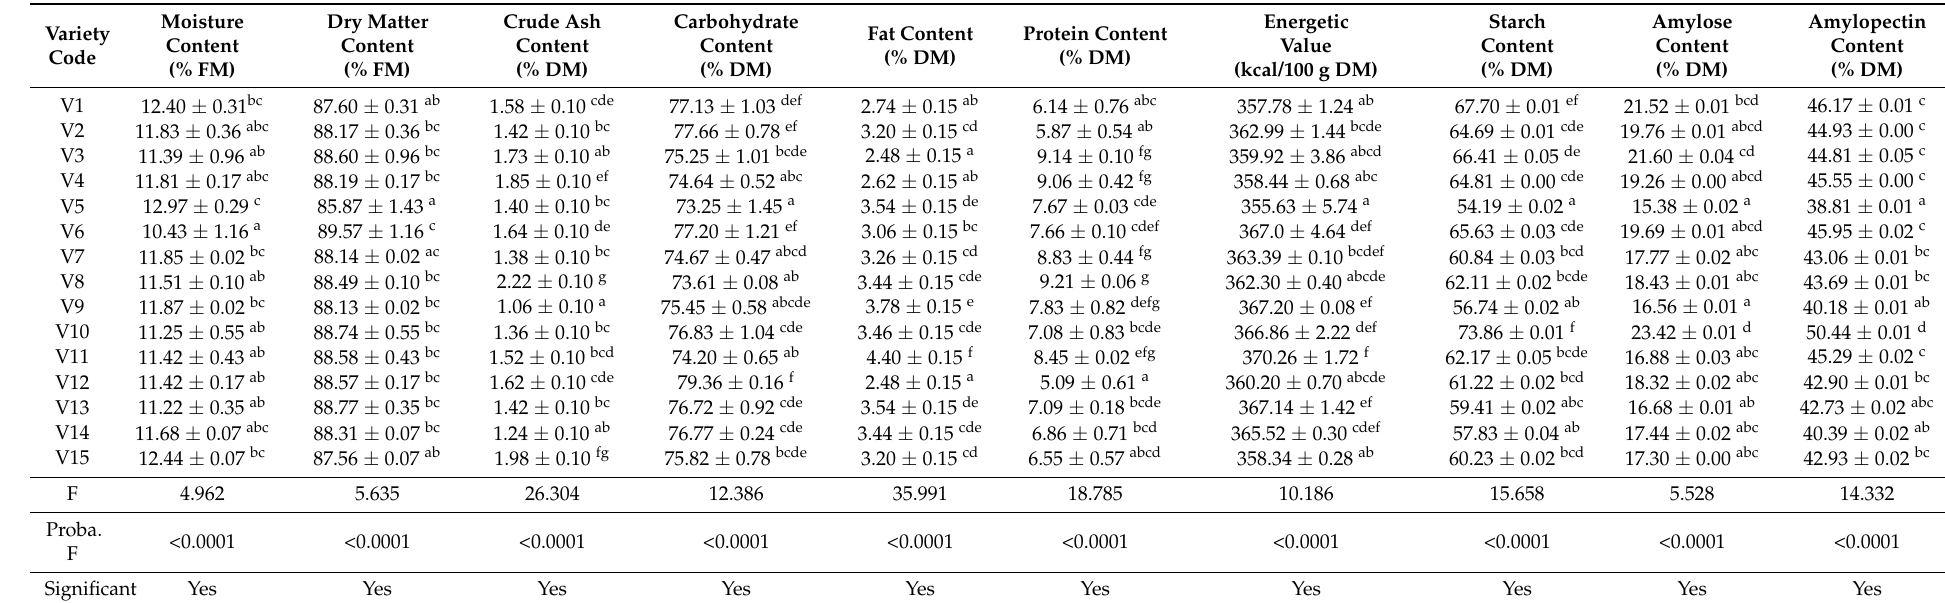
Table 3. Chemical analysis and nutritional potential of sorghum